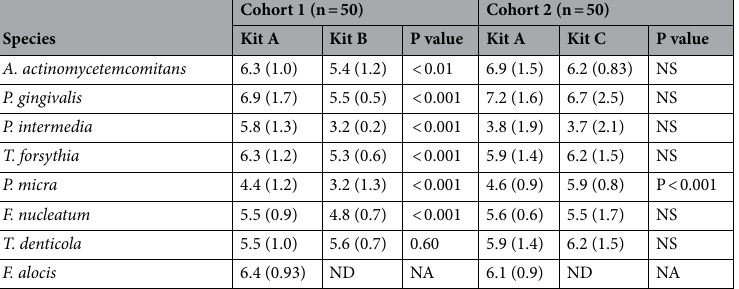
Table 3. 10 Log number of selected periodontal pathogens in samples tested positive by three different commercial qPCR test kits. ND not determined, NA not applicable.